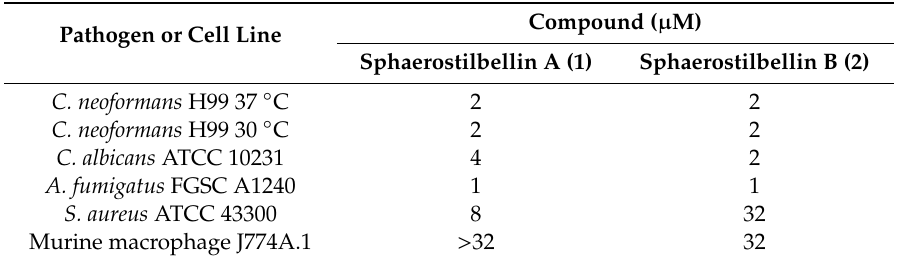
Table 3. Minimum inhibitory concentration (MIC) values of peptaibiotics 1 and 2 against selected pathogens and murine macrophage cell line J774A.1.